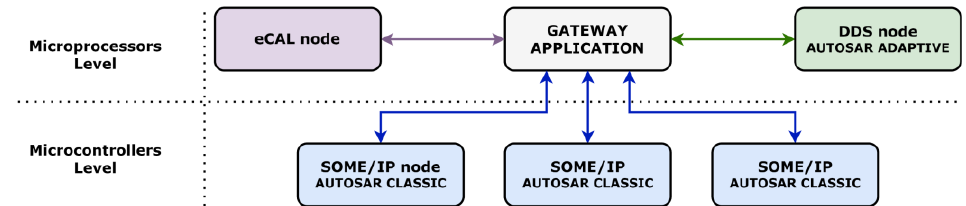
Figure 2. Second industrial applicability perspective for the gateway solution.